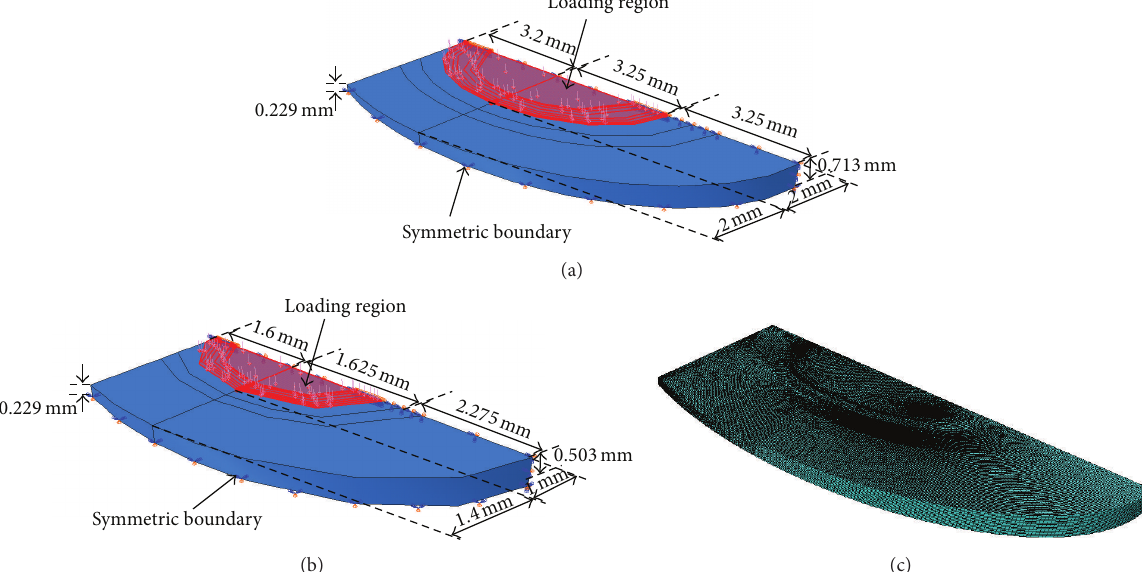
Figure 4: The dimensions of the 3D finite element model for (a) large spot processed and (b) small spot processed coupons. (c) Meshed model for large spot processed coupons.